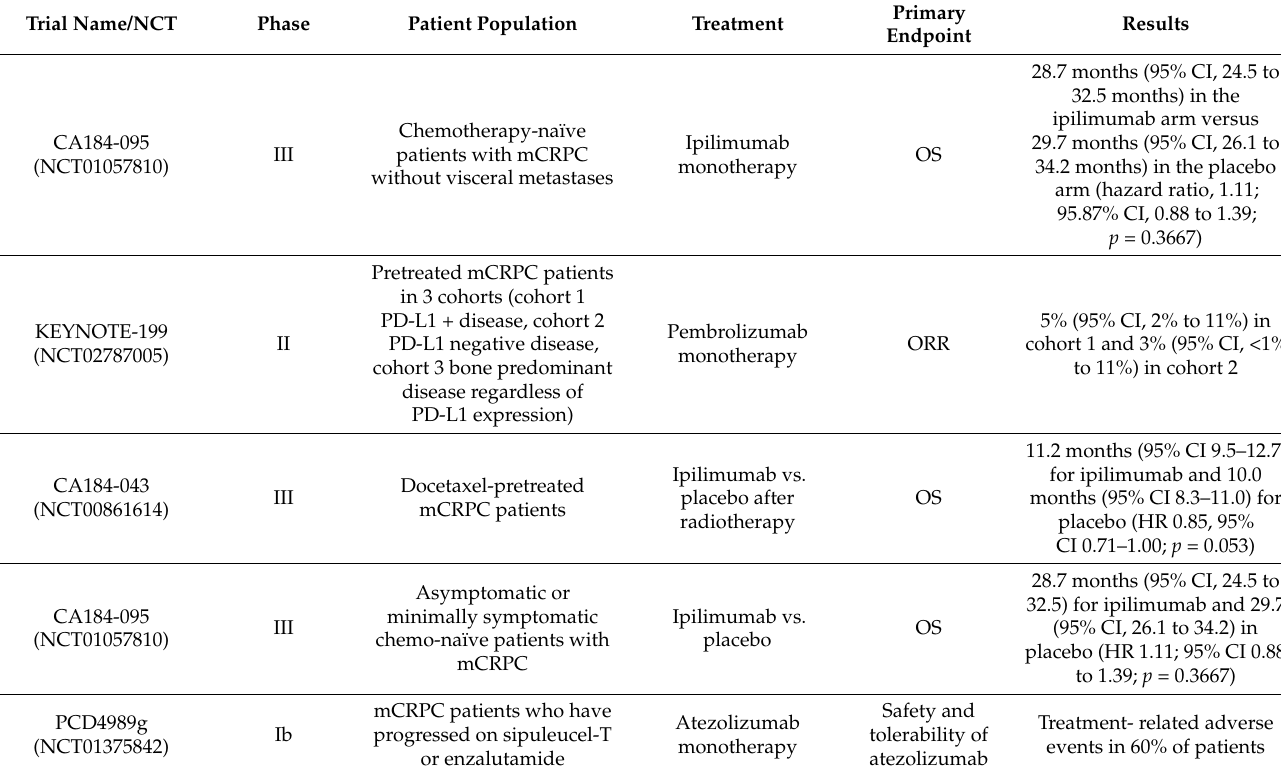
Table 1. Immune checkpoint inhibitor monotherapy evidence in